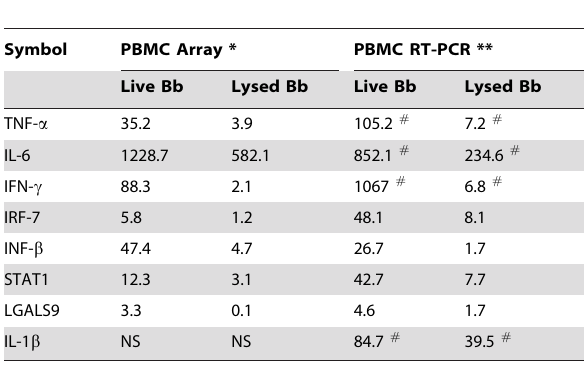
* Values are based on the normalized gene intensity values between live or lysed Bb vs. unstimulated cells. ** Values are based on fold increase/decrease in gene transcripts between live or lysed Bb and unstimulated cells. # These three values are adapted from experiments which were previously reported by Cruz et al.